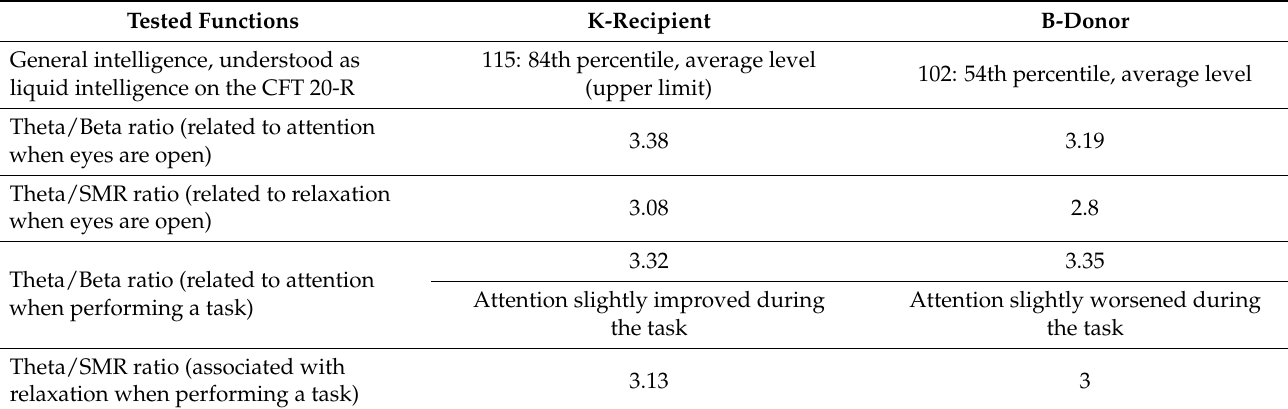
Table 1. Cognitive functioning and brain